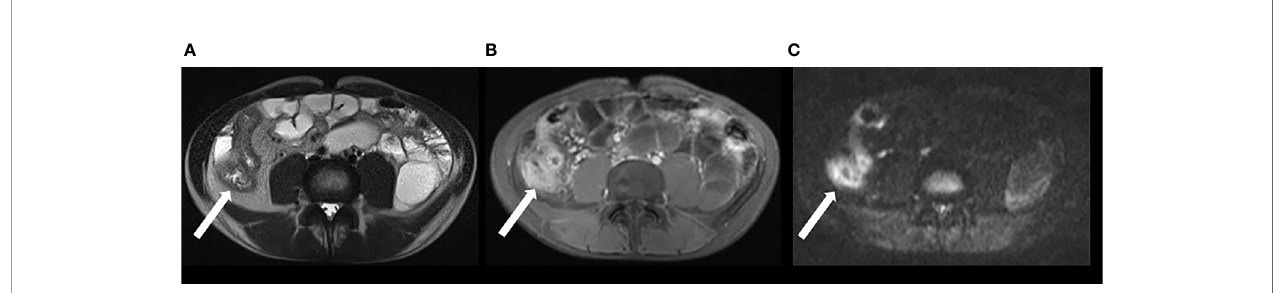
FIGURE 3 | MRI in patient with active CD involving the ileum: there is bowel wall thickening in T2w sequence (A) and increased contrast media uptake in T1w, fat suppressed imaging (B) . In fl ammation is also revealed by hyperintensity in DWI